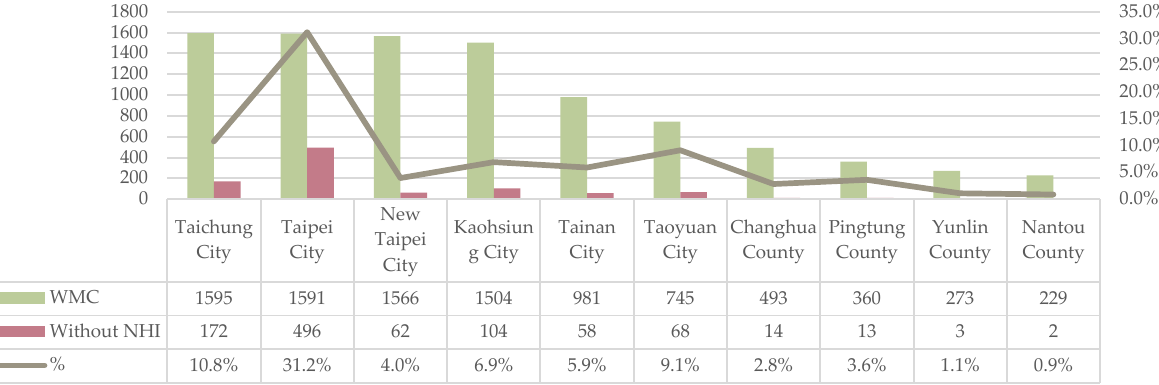
Figure 1. Geographical distribution of clinics without health insurance. WMC: Western Medical Clinic.